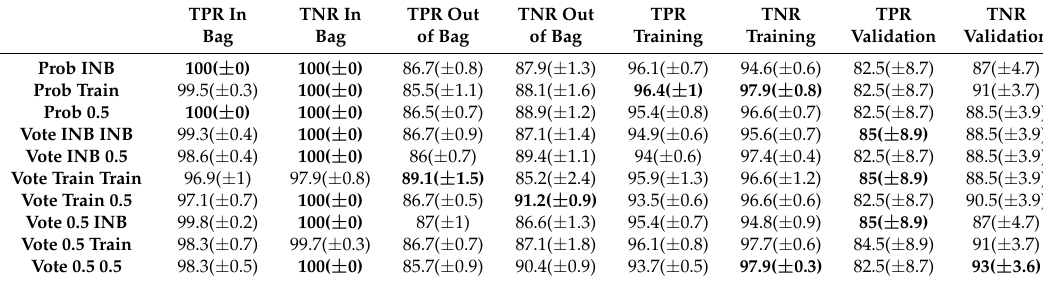
Table A5. True Positive Rate and True Negative Rate for Extreme Bradycardia.